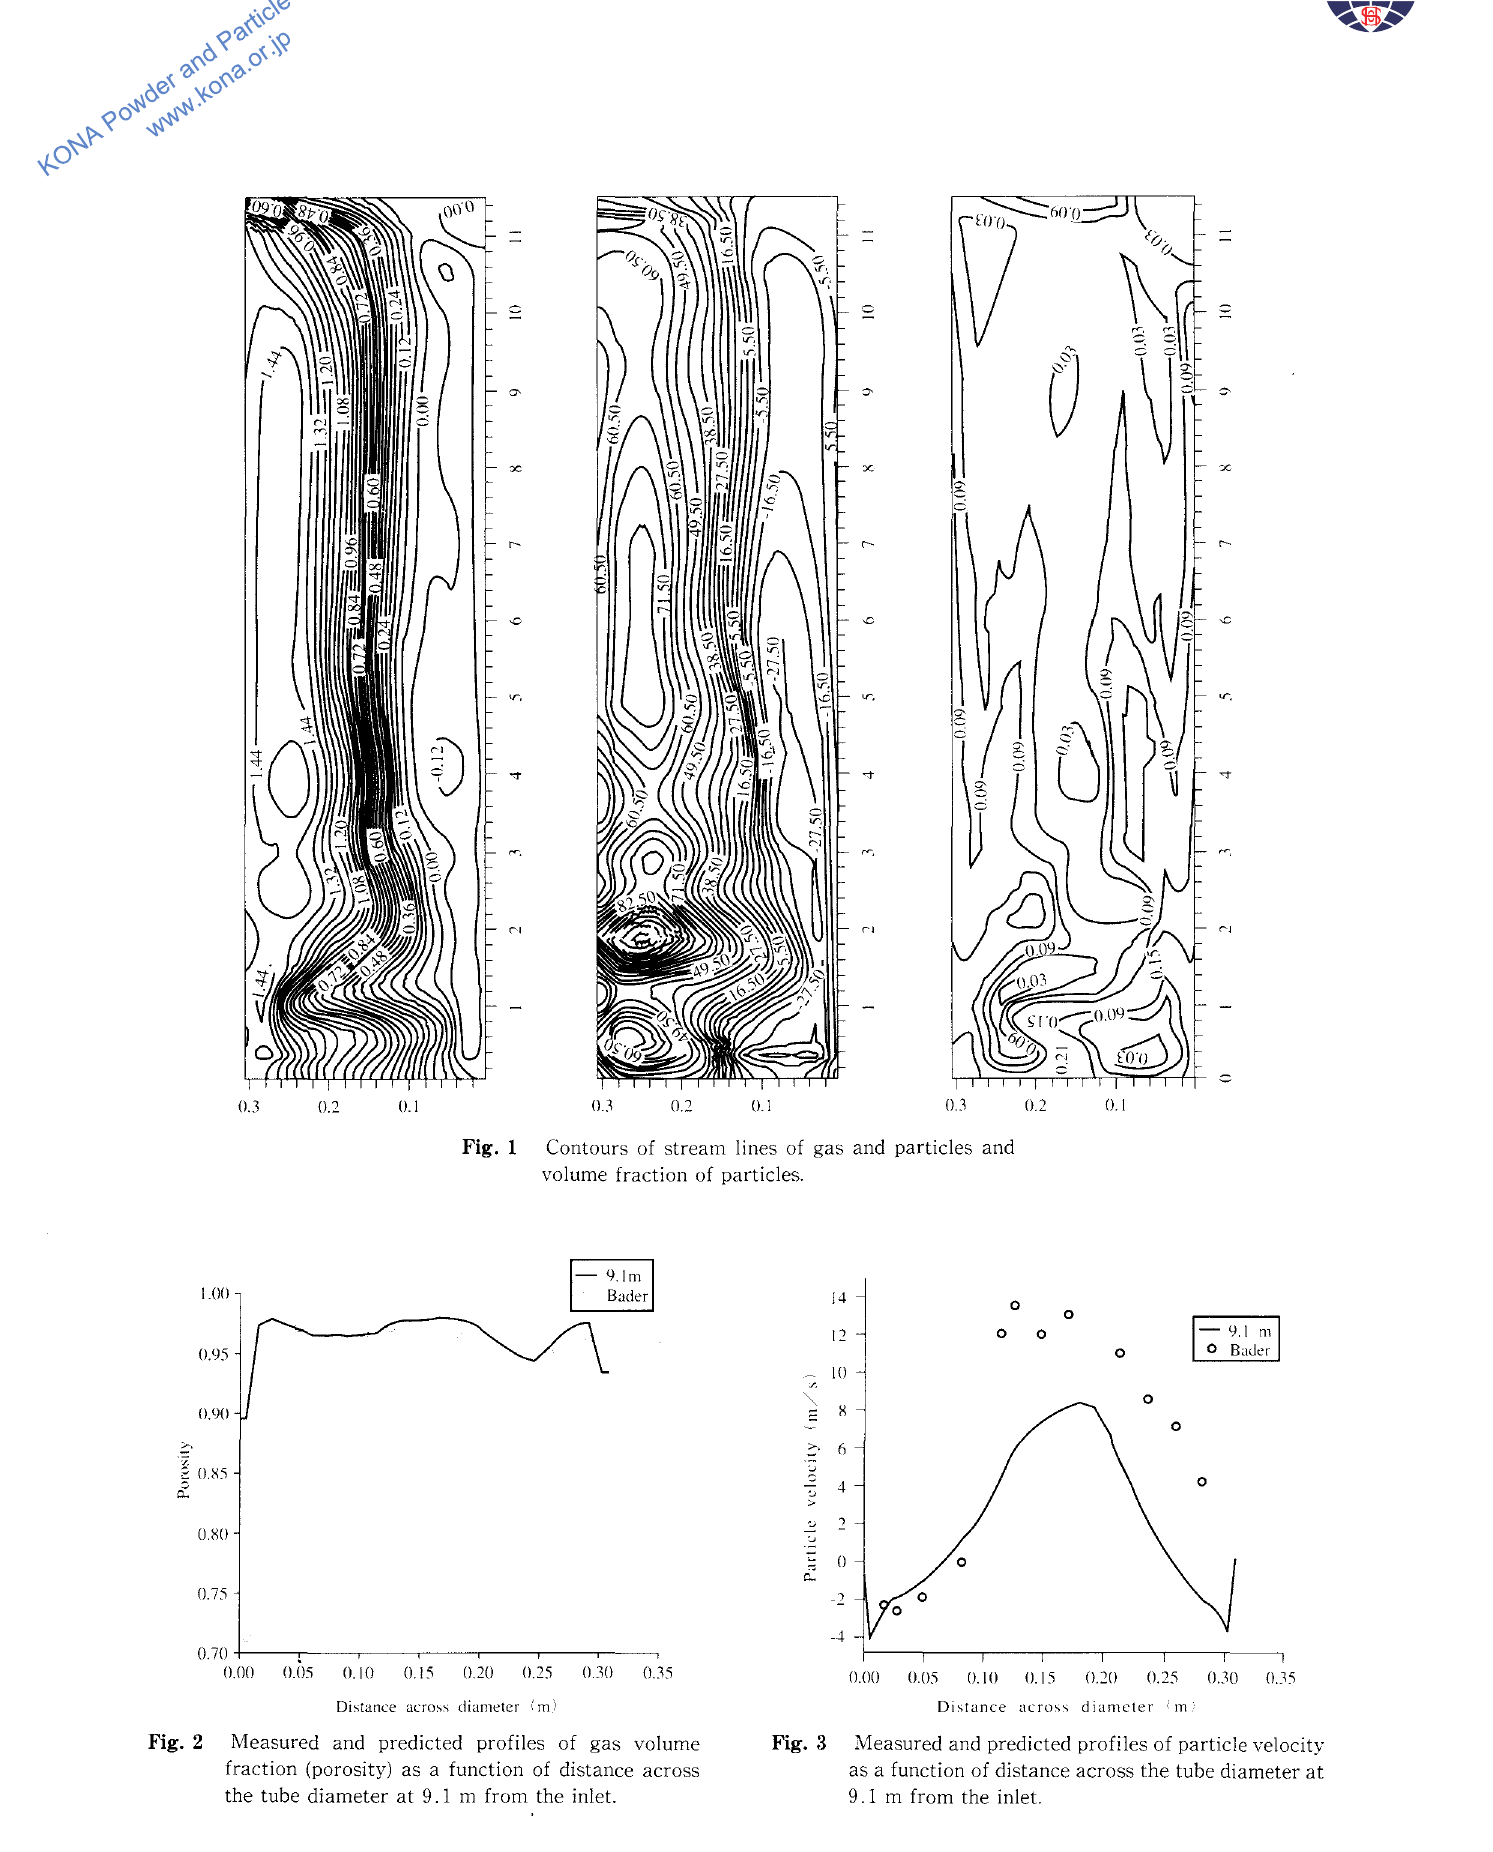
Fig. 2 Measured and predicted profiles of gas volume fraction (porosity) as a function of distance across the tube diameter at 9 .l m from the inlet.